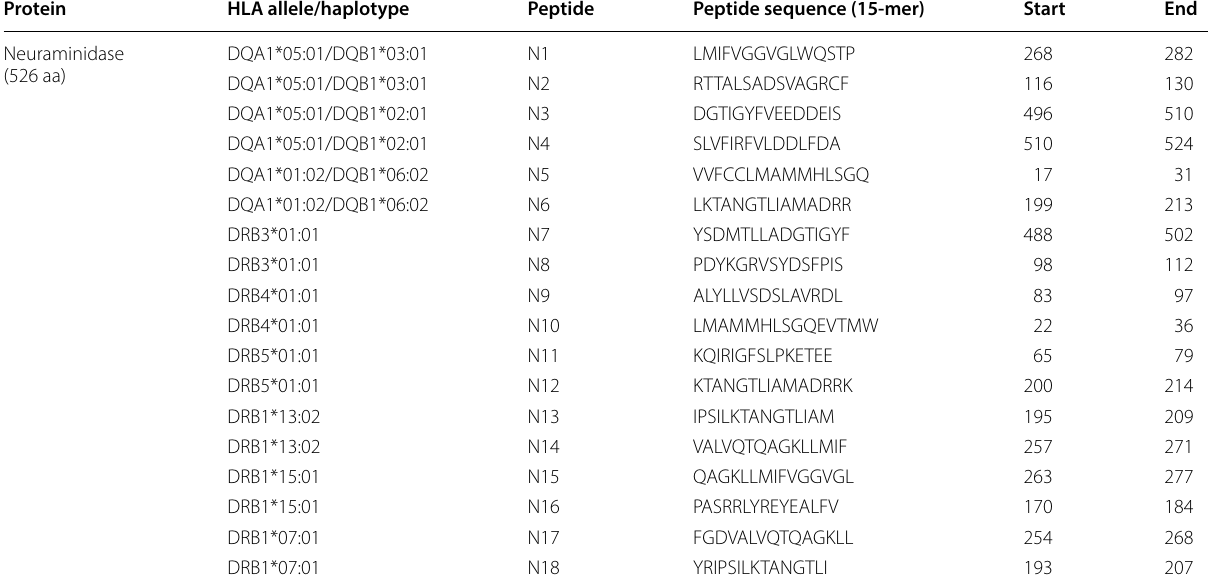
Start and end correspond to the positions in the protein sequence